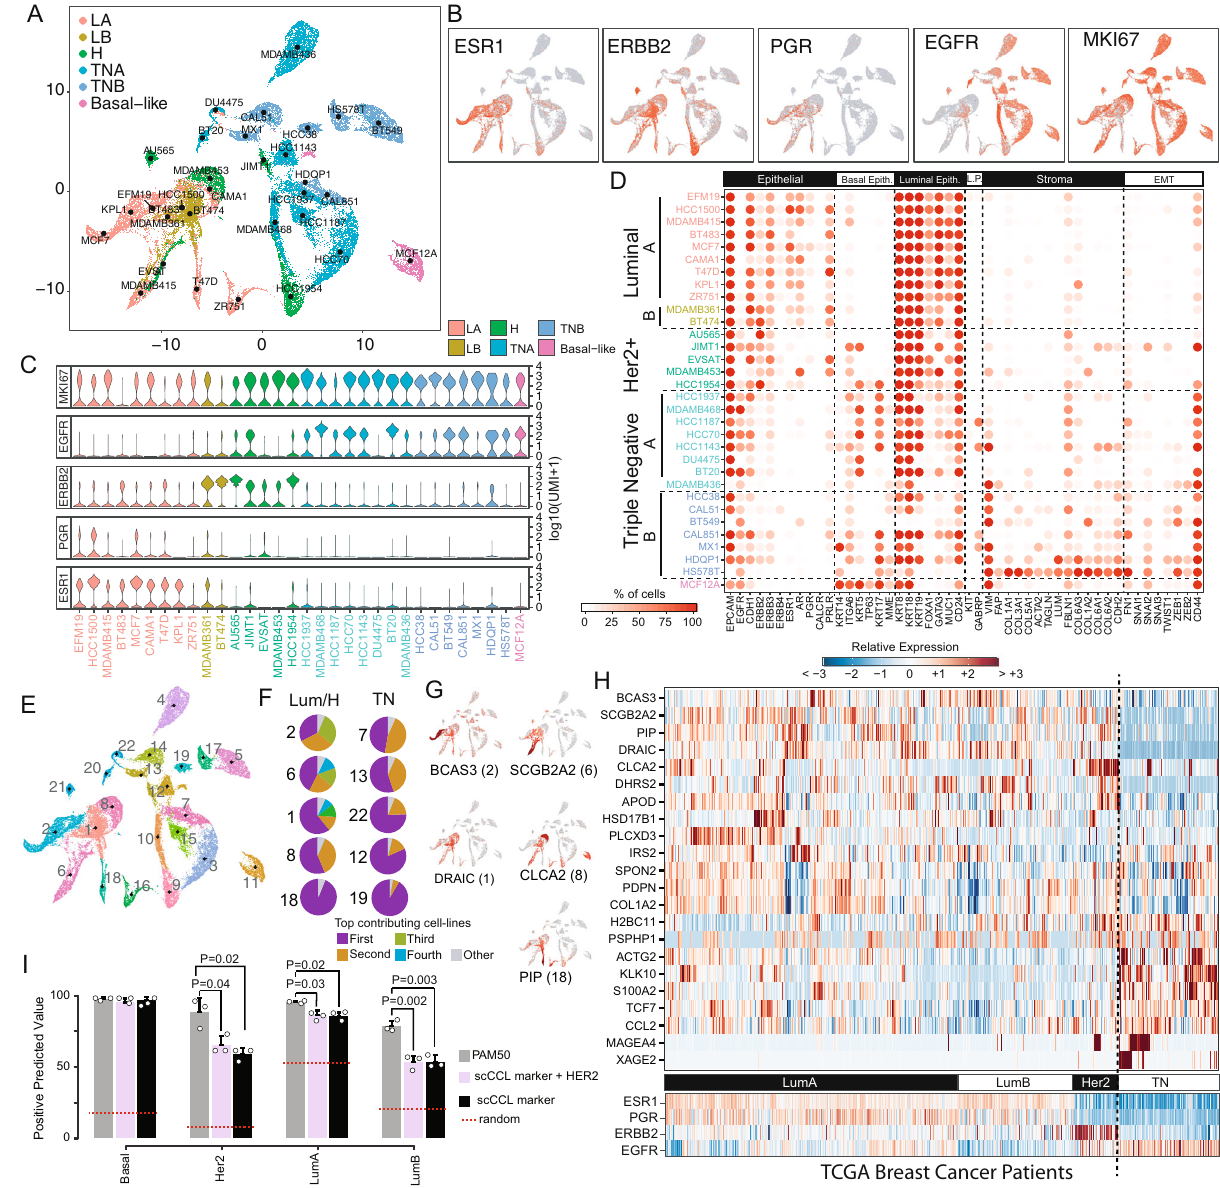
Fig. 1 The breast cancer single-cell atlas. A Representation of single-cell expression pro fi les of 35,276 cells from 32 cell lines color-coded according to cancer subtype (LA luminal A, LB luminal B, H Her2-enriched, TNA triple-negative type A, TNB triple-negative type B). B Expression levels of the indicated genes in the atlas, with red indicating expression, together with their C distribution within the cell lines, shown as a violin plot. D Dotplot of literature-based biomarker genes along the columns, for each of the 32 sequenced cell lines along the rows. Biomarker genes are grouped by type (Basal Epith. basal epithelial, Luminal Epith. luminal epithelial, L.P. luminal progenitor, EMT Epithelial to Mesenchymal Transition). E Graphical representation of 35,276 cells color-coded according to their cluster of origin. Clusters are numbered from 1 to 22. F For the indicated cluster, the corresponding pie chart represents the cluster composition in terms of cell lines. Cell lines in the same pie chart are distinguished by colour. Only the top 10 most heterogenous clusters are shown. In grey cell lines in the cluster contributing less than 5%, while the other colours represent a speci fi c cell line. For example, Cluster 2 is the most heterogeneous cluster mainly composed of 3 cell line while cluster 19 is the most homogeneous since in its mainly composed by the cells coming from one cell line. G Expression levels in the atlas of the fi ve luminal biomarkers identi fi ed as the most differentially expressed in each of the fi ve luminal clusters (1, 2, 6, 8 and 18). H Expression of 22 atlas-derived biomarkers in the biopsies of 937 breast cancer patient from TCGA. I Accuracy in classifying tumour subtype for 937 patients from TCGA by using either the PAM50 gene signature or the 22 cluster-derived biomarker genes (scCCL) alone or augmented with HER2 gene (scCCL + HER2). Two-sided t -test is used to compare the performance of the different signatures. Source data are provided in a Source data fi